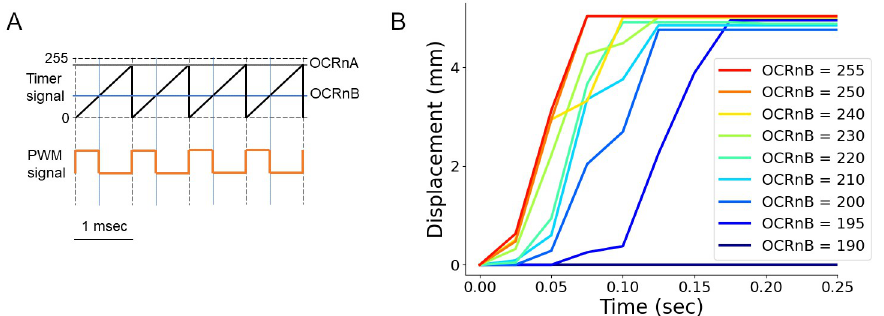
Fig 6. Testing suitable parameter configurations in the PWM control. (A) Schematic for the fast PWM mode. The level of OCRnA and OCRnB was set to control the frequency and duty cycle of the PWM signal, respectively. OCRnA was set to 249 to ensure a frequency of 1000 Hz. (B) Deformation of single segments with distinct duty cycles set by OCRnB.